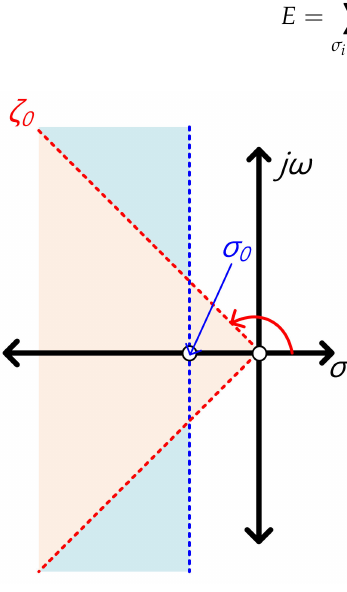
Figure 5. The D-shaped sector in the negative half of the